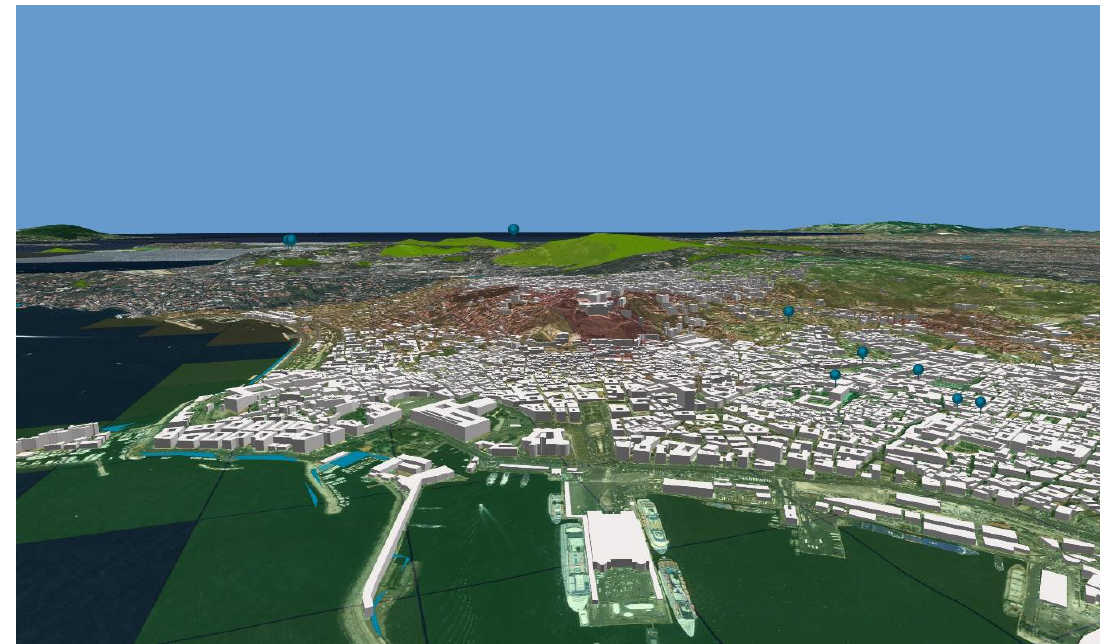
Figure 5. Excerpt of the 3D city model with the UES grid overlapped. The spatial relationships among building z-values and Regulation Services cell values are visualised.